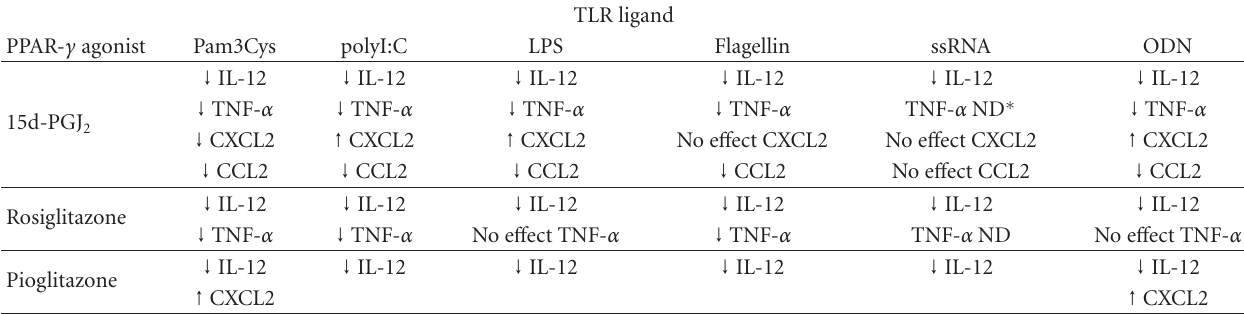
Table 1: Summary of PPAR- γ e ff ects on PAMP-activated microglia reported in this study.